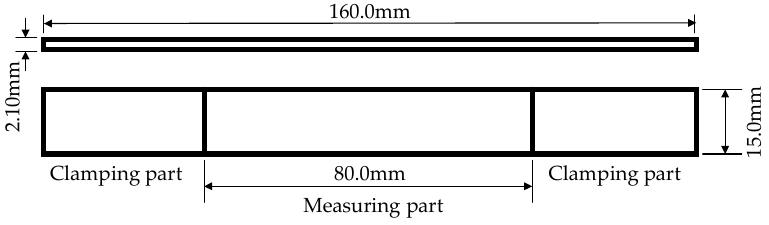
Figure 5. Continuous fiber-reinforced 3D printing tensile specimen.